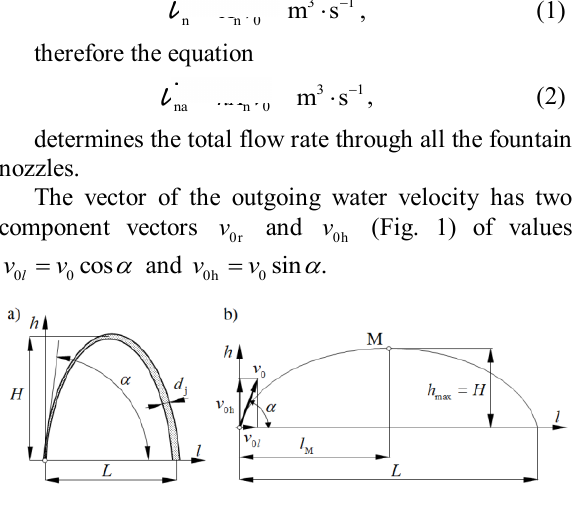
Fig. 2. Jet outgoing from nozzle a) throw with an angle to horizontal plane, b) schematic for rough